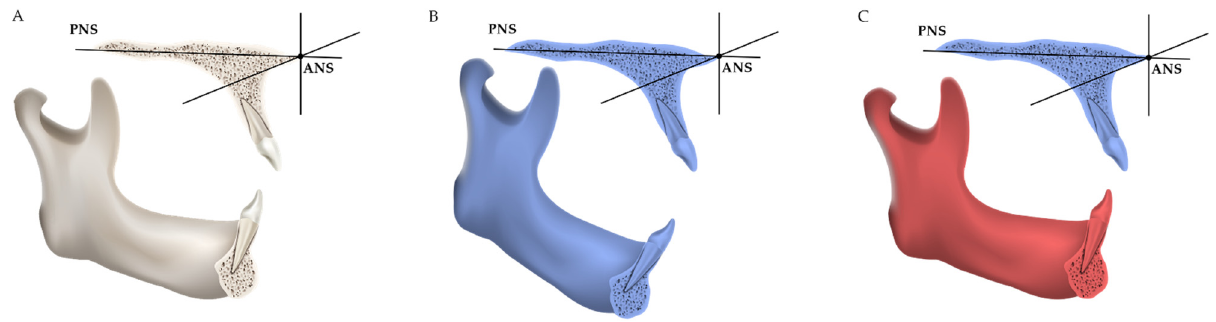
Figure 2. Schematic diagrams of the measurement method: ( A ) T0 structures were in white. T0 coordinate system was used for the measurement of T0 maxillary and mandibular structures; ( B ) T1 structures were in blue. T1 coordinate system could not be used for the measurement of T1 mandibular structures because of mandibular position change; ( C ) T2 (i.e., the reoriented T1) mandibular structures were in red. T1 coordinate system was used for three-dimensional measurement of T1 maxillary and T2 mandibular structures.